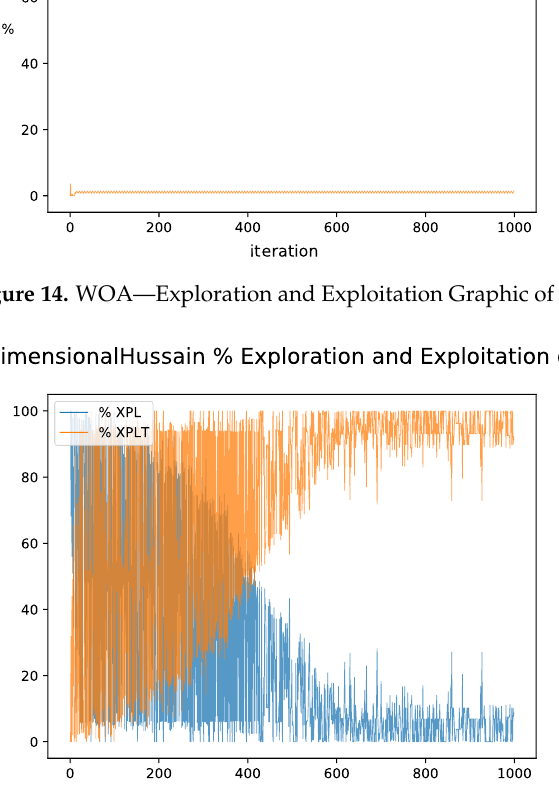
Figure 15. WOA—Exploration and Exploitation Graphic of instance d4 version QL5.